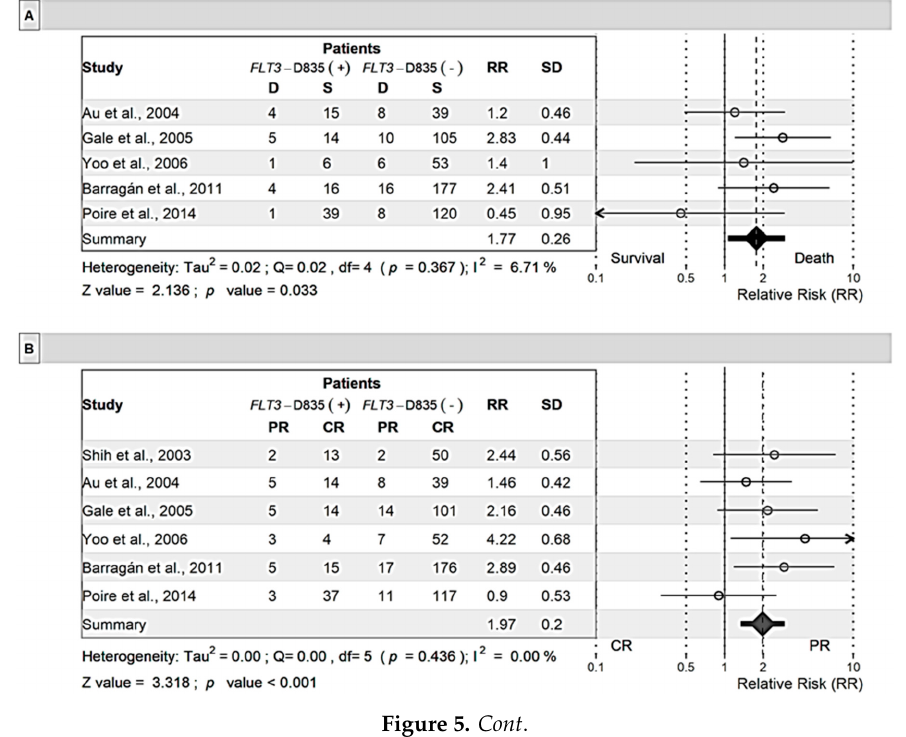
Figure 4. Meta-analysis of the relative risk for patients with the FLT3 -ITD mutation. Induction death